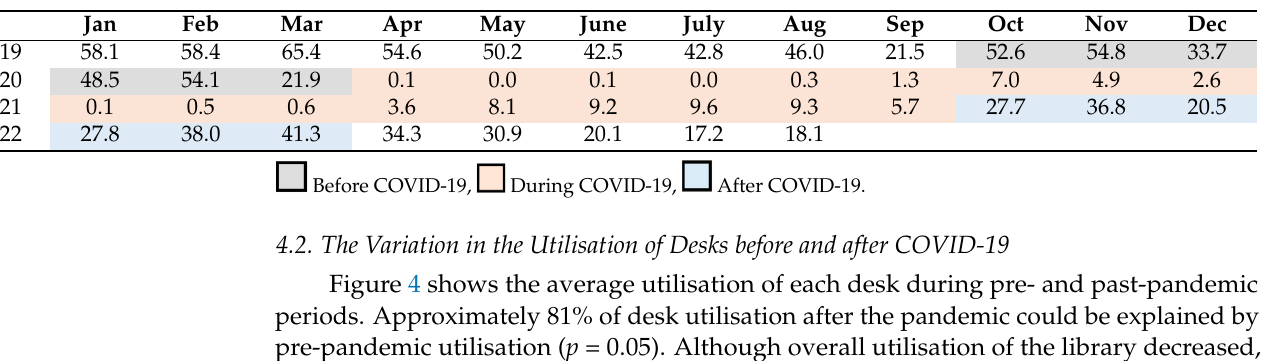
Table 2. Average utilisation of the library since 2019 (%) before, during and after